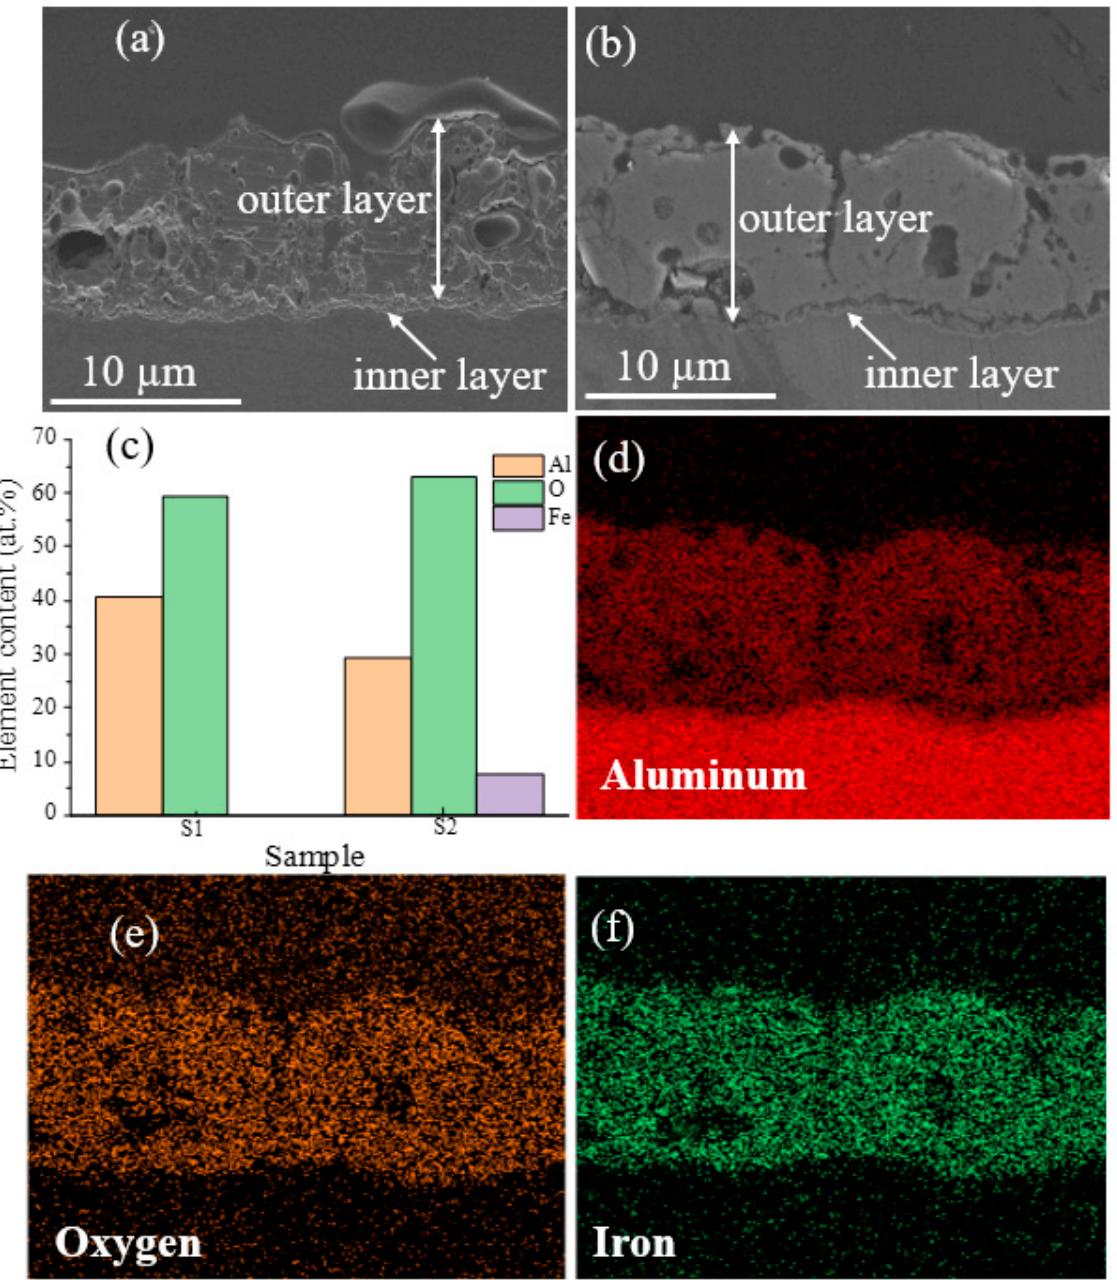
Figure 3. SEM images of the cross-sectional morphologies of the coatings made on S1 and S2 samples: ( a ) S1 and ( b ) S2. ( c ) EDS area analysis on the surface of S1 and S2 samples. ( d – f ) EDS mappings on the cross-section of the S2 sample show the presence of Al, O, and Fe, respectively.